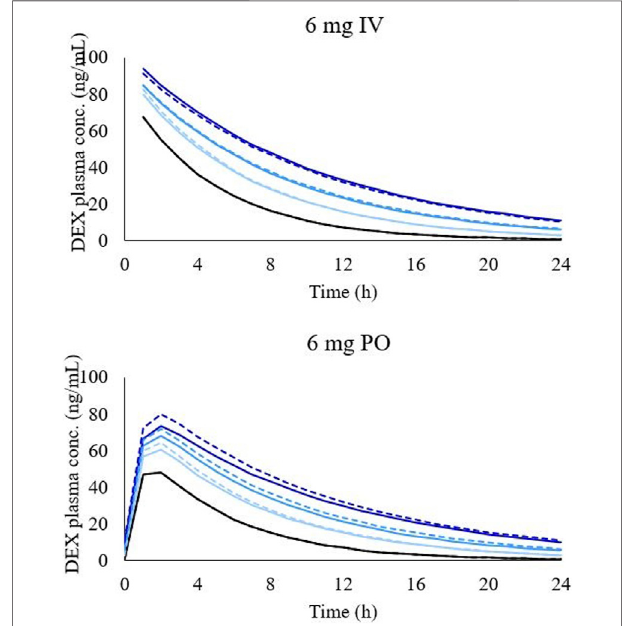
FIGURE 2 | Simulated concentration-time pro fi le of DEX in different LD conditions after 6 mg intravenous administration (graph on the top) and 6 mg oral administration (graph on the bottom). Black line, healthy individuals. Light blue line, CP-A condition, blue line, CP-B condition, and dark-blue line, CP-C condition. Dashed lines represent simulations with shunting and solid lines with no